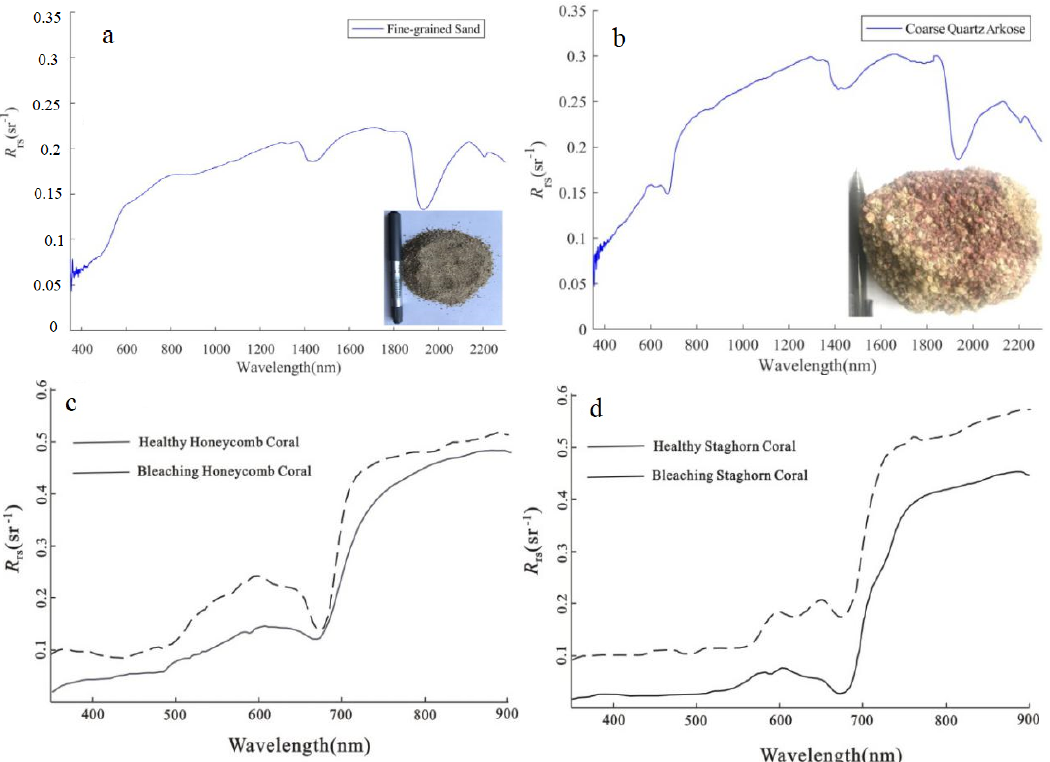
Figure 18. The spectra of different types of bottoms: ( a ) the fine-grained sand sample collected from a sandy coastline and its spectrum, where the sample point is at 109°22’10.36’’ and 18°17’21.40’’; ( b ) the coarse quartz arkose sample collected from a rocky coastline and its spectrum, where the sample point is at 109°22’10.36’’ and 18°17’21.40’’; ( c ) the spectra of healthy and bleaching honeycomb corals; ( d ) the spectra of healthy and bleaching staghorn corals.